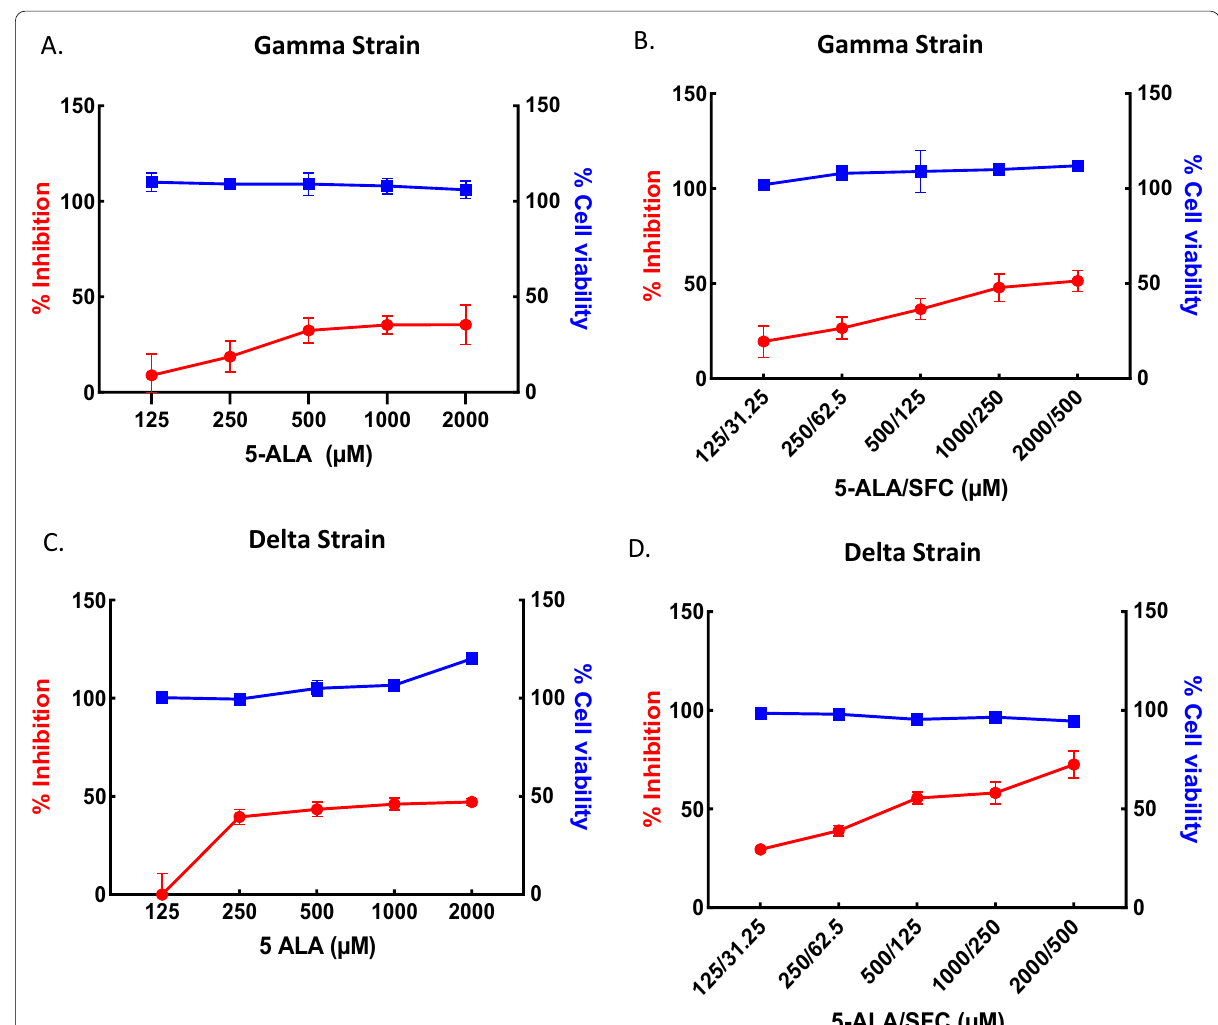
Fig. 3 Antiviral effect of 5-ALA (panels A and C ) and 5ALA with SFC (panels B and D ) against Gamma (panels A and B ) and Delta (panels C and D ) strains. Vero E6 cells were pretreated with ALA with and without SFC for 72 h and challenged with SARS-CoV-2. Infected cell supernatants at 48 h pi (MOI 0.02) were quantified by quantitative real time RT-PCR assay. The blue and red lines represent the CC 50 and IC 50 , respectively; the blue squares represent cell viability (%) and the red circles represent SARS-CoV-2 infection inhibition (%). All experiments were performed in